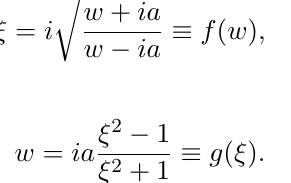
(0) Figure 5 . ∆ S after a single joining quench in a Dirac free fermion CFT, where S (0) A = S A − S A is the EE of the vacuum state. A = [50 , 100] in the left figure and A = [0 . 1 , 1000] in the right figure. We set a = 0 .